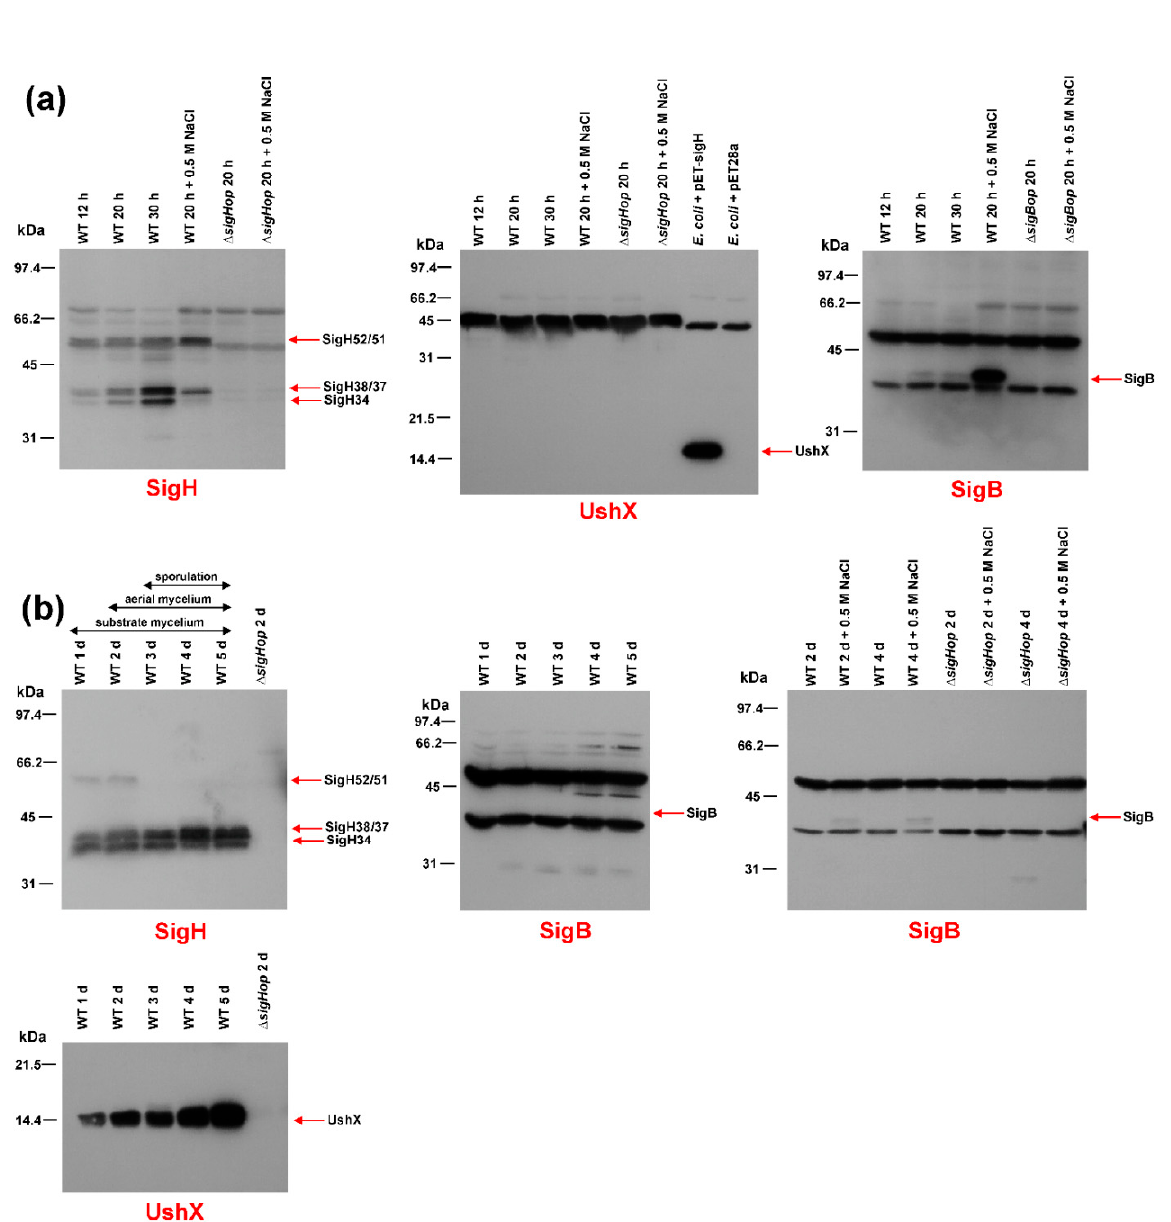
Figure 1. Western blot immunodetection of SigB, SigH and UshX. Crude protein extracts (30 µ g) prepared from the wild-type S. coelicolor M145 strain (WT) or S. coelicolor ∆ sigBop or ∆ sigHop mutant strains were analyzed on a 12.5% SDS-PAGE, transferred to a nitrocellulose membrane and detected with the antibody indicated under each blot. ( a ) Crude protein extracts were prepared from the above strain, which was cultured in NMP liquid minimal medium for 12 h (early exponential phase), 20 h (late exponential phase), and 30 h (stationary phase). The crude extracts under osmotic stress conditions were prepared from cultures grown for 20 h (exponential phase) and incubated for 30 min in the presence of 0.5 M NaCl. The E. coli BL21(DE3) strain with the plasmid pET-sigH or pET28a was grown to exponential phase. ( b ) Crude protein extracts were prepared from the indicated strain grown on cellophane discs placed on the surface of solid agar minimal medium MM for 1 day (vegetative substrate mycelium), 2 days (beginning of aerial mycelium formation), 3 days (aerial mycelium), 4 days (septation of aerial mycelium), and 5 days (spore maturation). Crude extracts under osmotic stress conditions were prepared from the cultures similarly grown to indicated time points in solid minimal MM medium with 0.5 M NaCl. The position of the specific band for each protein is indicated by an arrow. The positions of the bands in the protein standard are shown on the left. The presence of both sigma factors was similarly examined during morphological solid minimal MM medium containing 0.5% mannitol to different developmental